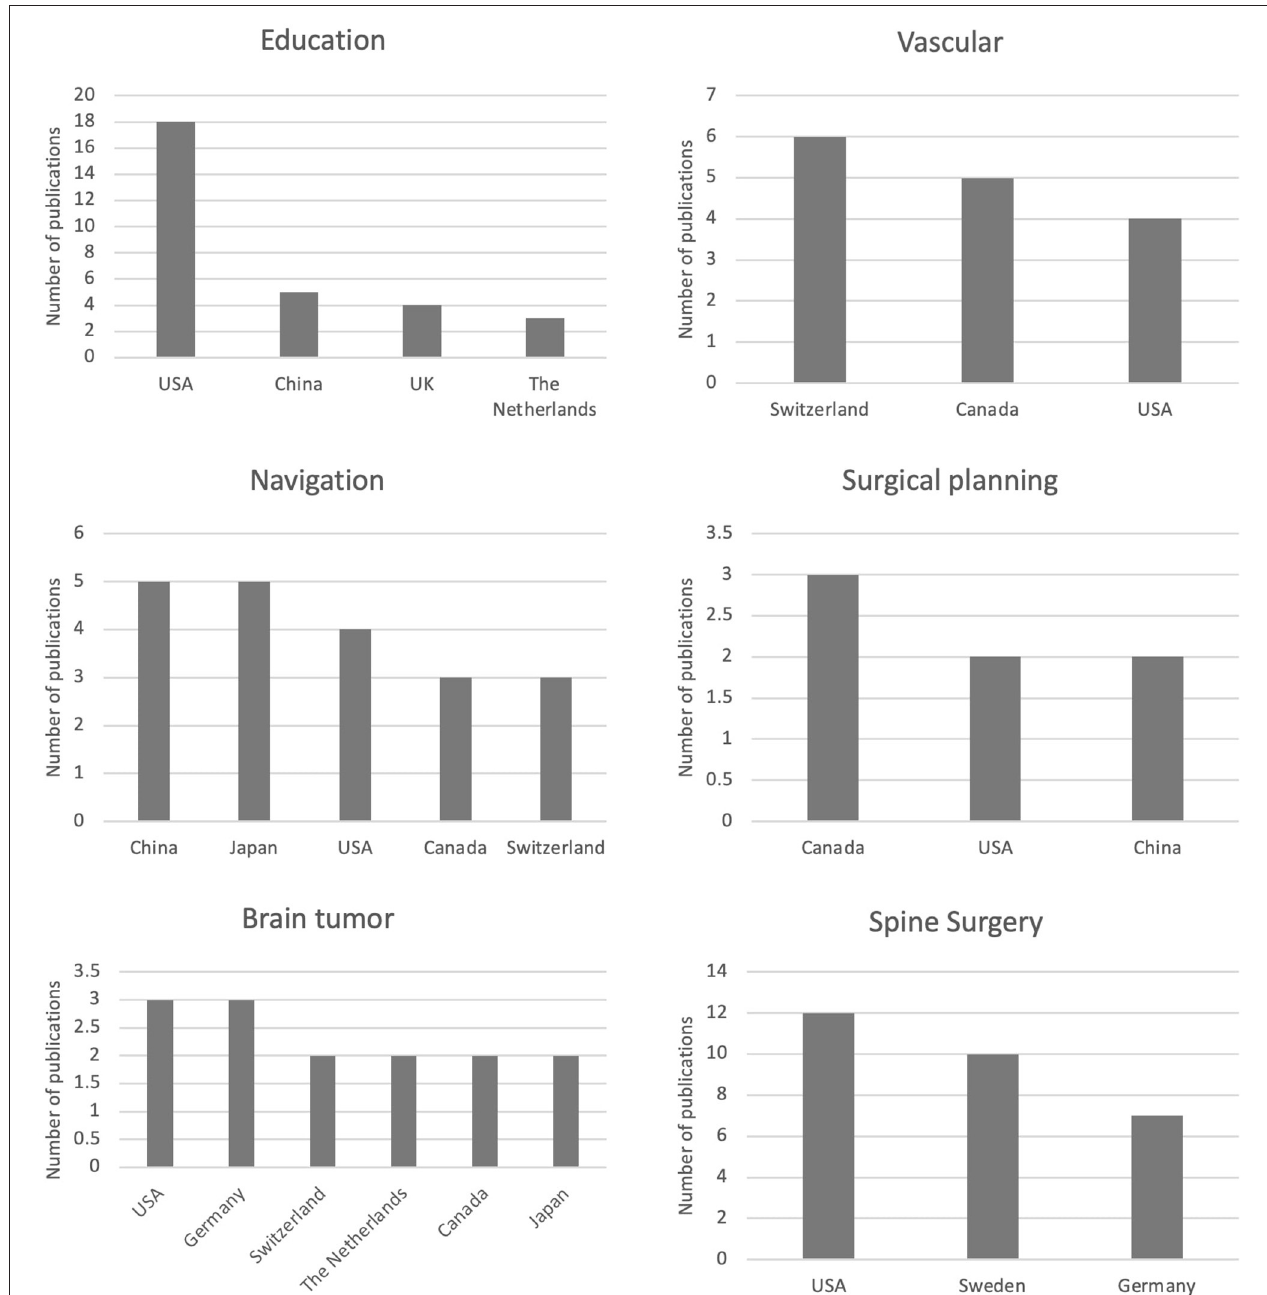
FIGURE 6 | Diagram showing the number of publications per topic per country.